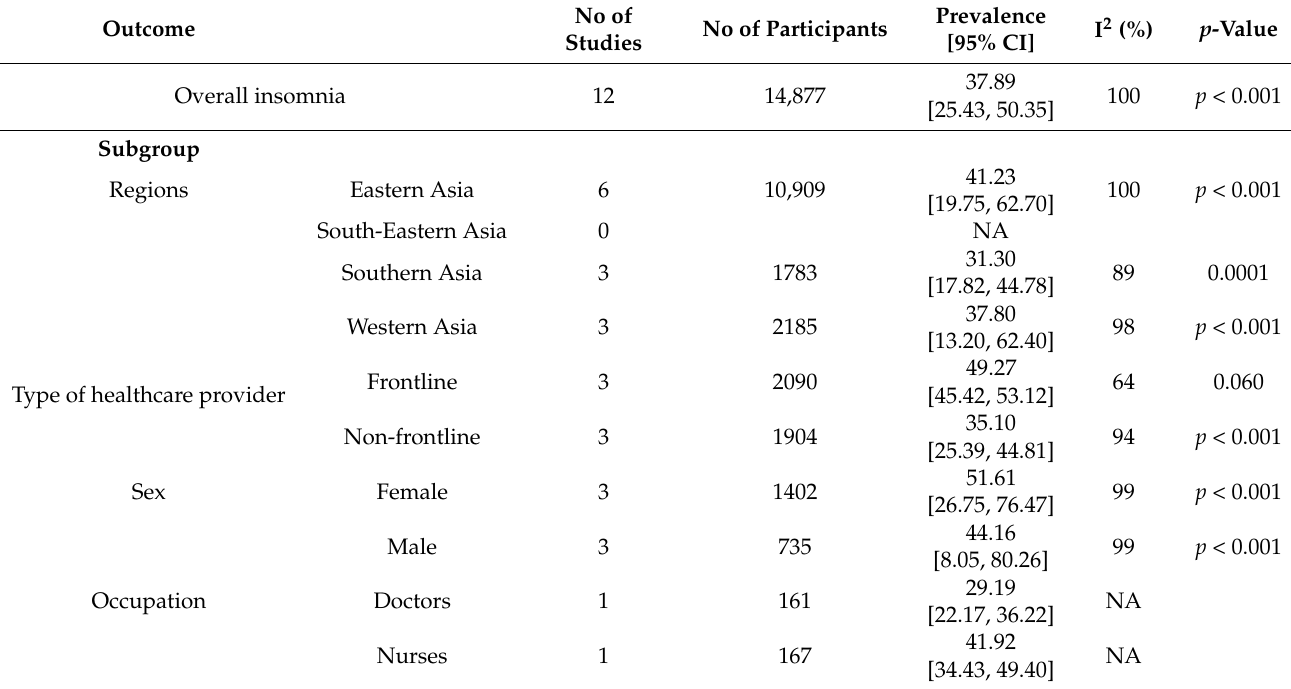
Table 4. Pooled prevalence of insomnia and subgroup